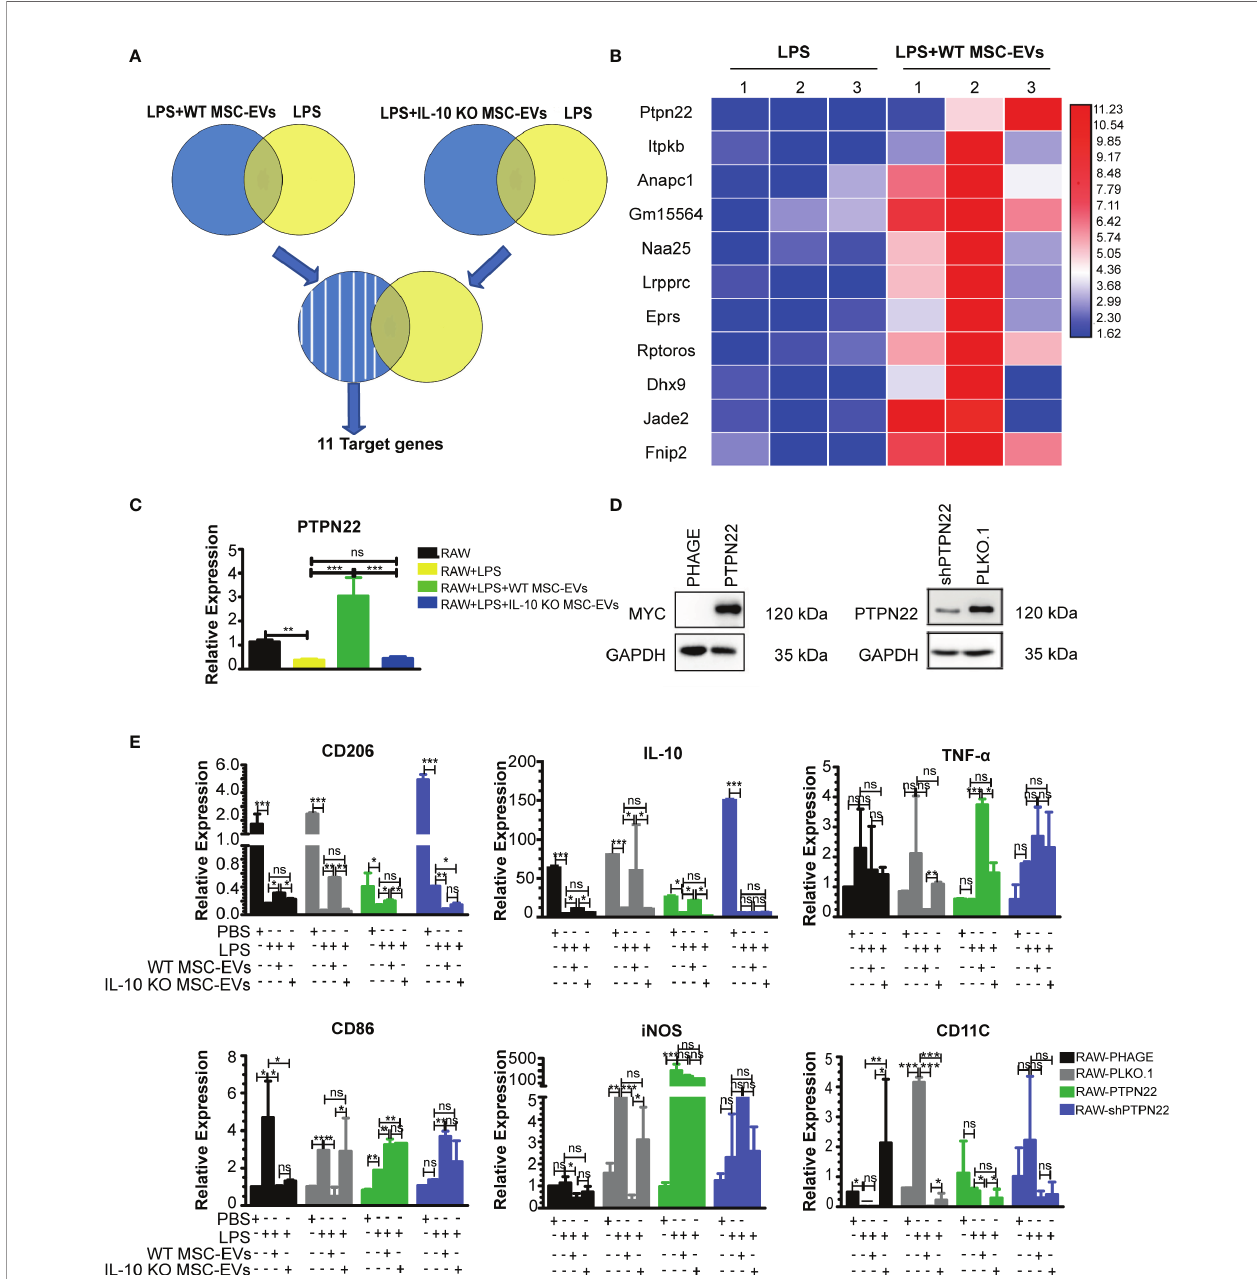
FIGURE 6 | PTPN22 is important for WT MSC-EV-mediated anti-in fl ammatory polarization of RAW264.7 cells. (A) Experiment outline: RAW264.7 cells were pre- exposed to LPS (100 ng/ml) for 12 h, treated with EVs for either WT or IL-10 KO MSCs for another 12 h, and subjected to RNA sequencing. Differentially expressed genes (Log |FC| ≥ 2 and P < 0.05) were analyzed. (B) Heat map screen of the top 11 differential genes according to transcriptome sequencing. (C) RT-PCR analysis of the mRNA level of PTPN22 in RAW264.7 cells treated with the indicated groups. (D) Western blotting analysis of PTPN22 in RAW264.7 cell lines with overexpression of PTPN22 (phage-PTPN22) and its control (phage-MYC) (left panel); as well as in RAW264.7 cell lines with knocking down the expression of PTPN22 (shPTPN22) and its control (PLKO.1) (The amount of protein loaded is 20 m g). The PLKO.1 was de fi ned as the control of RAW264.7 cells with knocking down the expression of PTPN22 gene. The shPTPN22 was de fi ned as the RAW264.7 cells with knocking down the expression of PTPN22 gene. The MYC was de fi ned as the control of RAW264.7 cells with PTPN22 gene overexpression. (E) PTPN22 over-expressing or down-regulated RAW264.7 cells were exposed to LPS for 12 h and then treated with 20 m g of MSC-EVs or IL-10 KO MSC-EVs for another 12 h The mRNA levels of pro-in fl ammatory markers (TNF-in CD86, iNOS, CD11C) and anti-in fl ammatory markers (IL-10, CD206) were detected by RT-PCR. *P < 0.05, **P < 0.01, ***P < 0.001; ns, not signi fi cant. There were three samples (individual biological sample) in each group. All data are shown as the means ±